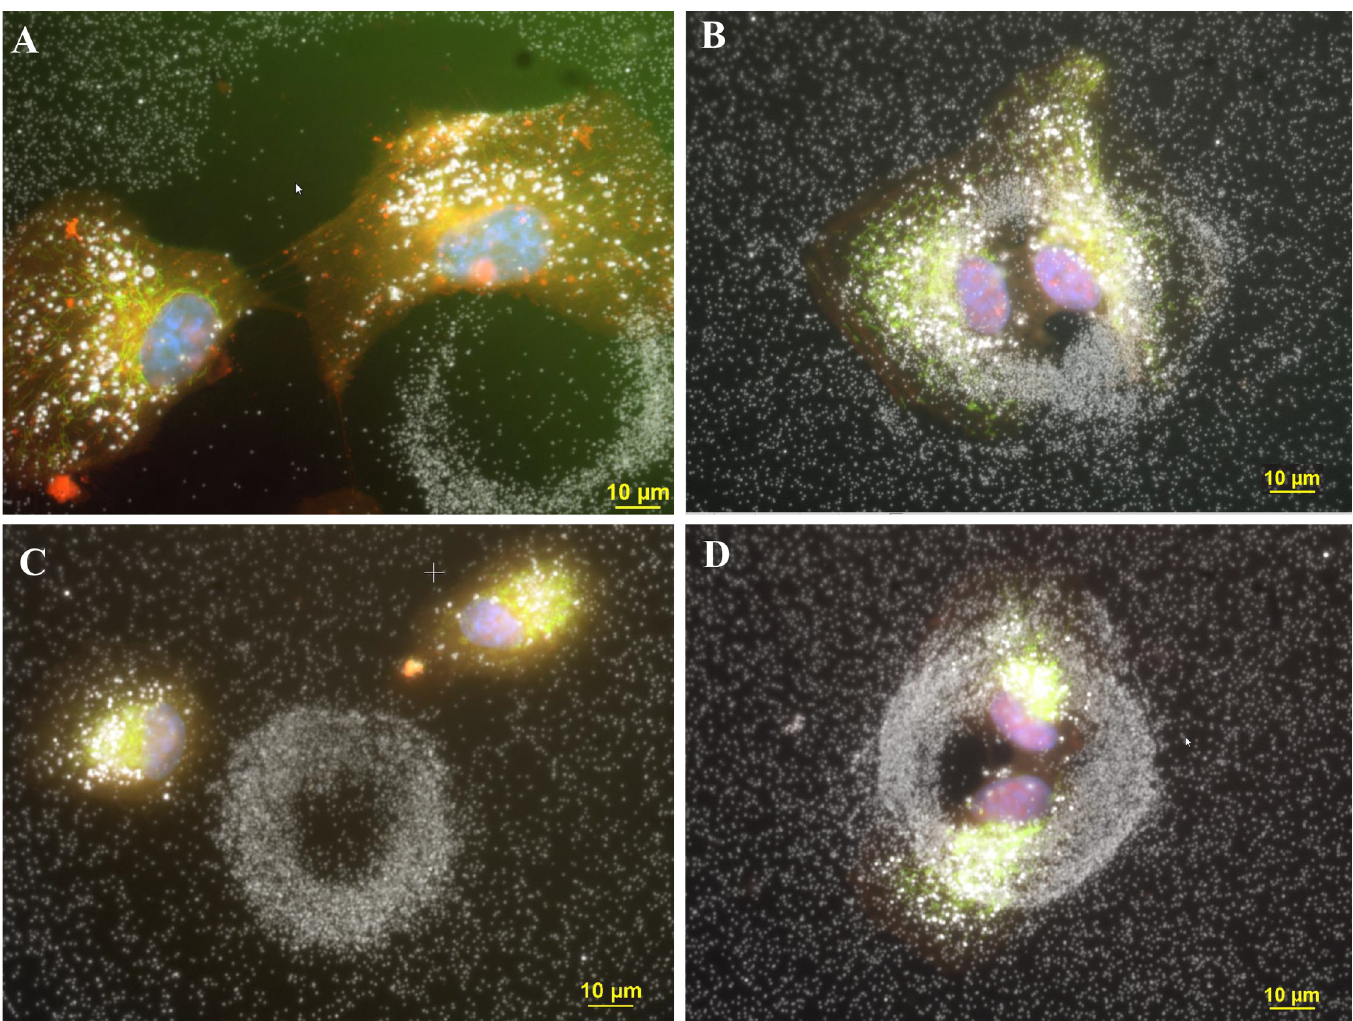
Fig 2. Four different fields of cells treated with 3ug/ml AgNP citrate contained circles that was visualized obtained with darkfield optics using a 60-x plan Fluor objective with an iris diaphragm (NA 0.55–0.90). Panel A. Two cells are located outside the nanoparticle circle that have an accumulation of intracellular nanoparticles that are brighter than the extracellular nanoparticles. The particles in the extracellular ring have similar brightness to other extracellular particles. Magnification 600x. Panel B. Two cells in mitosis is visible inside the nanoparticle circle. The cells were stained with CellMask Orange plasma stain (red) to reveal the cytoplasm and DAPI (blue) to reveal the nucleus. Since the mitotic cells are round, some of the colors of red cytoplasm have blended with the blue nuclei to yield a purple color. Cells were transfected with Mito-GFP (green). The two apparently mitotic cells are surrounded by a single nanoparticle ring structure. The circle diameter size is 54 μ m, the center hole diameter is 30 μ m and nuclear diameter is 18.7 μ m. Magnification 600x. Panel C. Two post-mitotic daughter cells were observed near a large ring structure. The circle diameter is 56 μ m, hole diameter is 23 μ m, and circle wall thickness is 16 μ m. Magnification 600x. Panel D. Two post-mitotic daughter cells were observed within a larger ring structure The circle diameter is 62 μ m, the center diameter is 30 μ m, and circle rim thickness is 15 μ m. Magnification 600x.